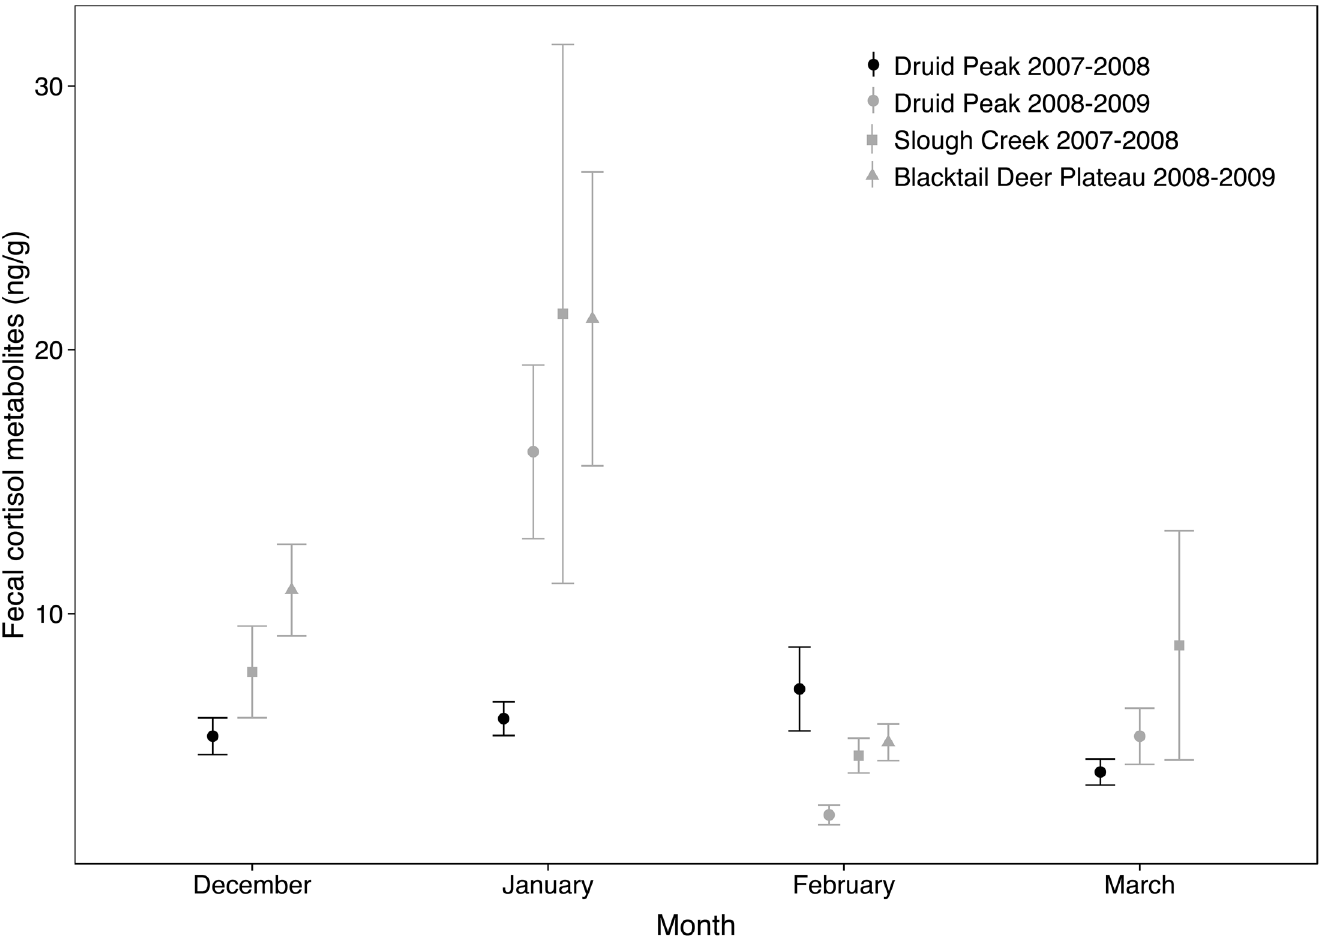
Fig 2. Monthly mean fecal cortisol metabolites levels measured in a socially and territorially stable wolf pack (Druid Peak 2007 – 2008) and in three unstable packs (Slough Creek 2007 – 2008, Druid Peak 2008 – 2009 and Blacktail Deer Plateau 2008 – 2009) in Yellowstone National Park (USA). Error bars represent standard